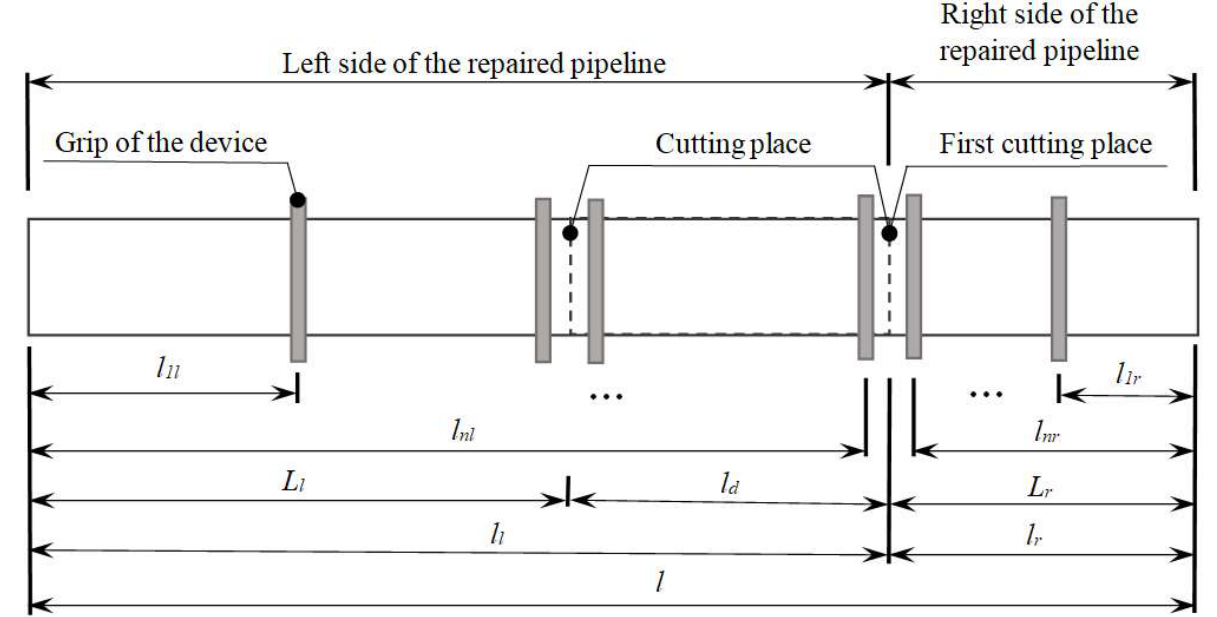
Figure 8. Symbols for calculating the reaction forces X ic according to the proposed mathematical model: l 1 , l 2 , l n —distances from the place where the pipeline enters the pit to the places where the grips are installed, m; l —length of the pipeline from the wall of the trench to the cutting point, m; l l , l r —respectively, the length of the left and right sides of the pipeline after the first cut, m; L— length of the centered side of the pipeline, equal to the original length l l , l r of the side of the pipeline, if the cut out section is outside it, and equal to L minus l д , if the cut out section is on this side, m; l д —length of the cut out section of the pipeline, m.